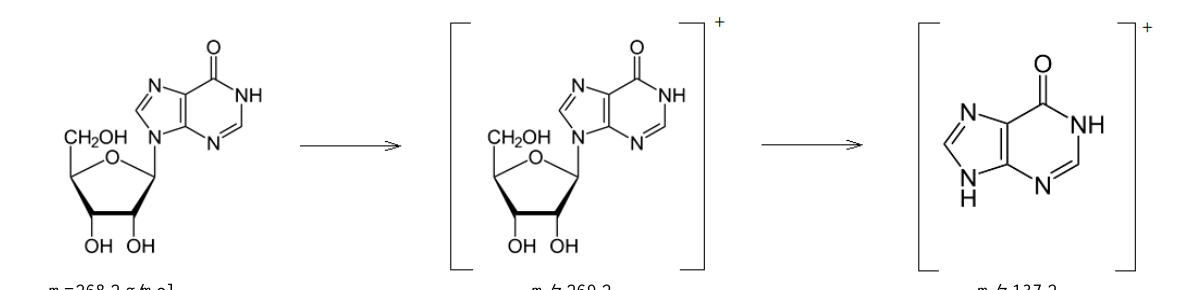
Fig. 4. The scheme of the riboxinum fragmentation in